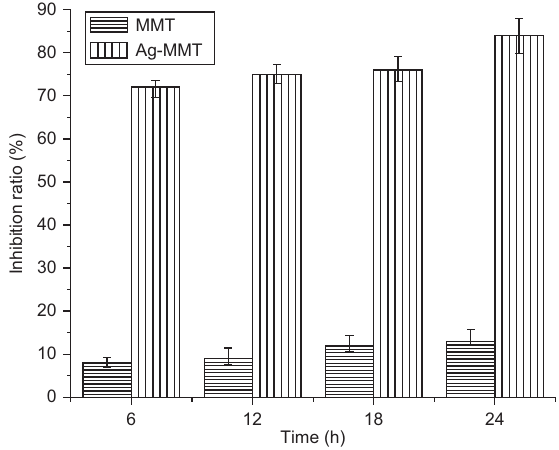
Figure 10 Quantitative evaluation of the inhibition ability to S. aureus of MMT and Ag-MMT.